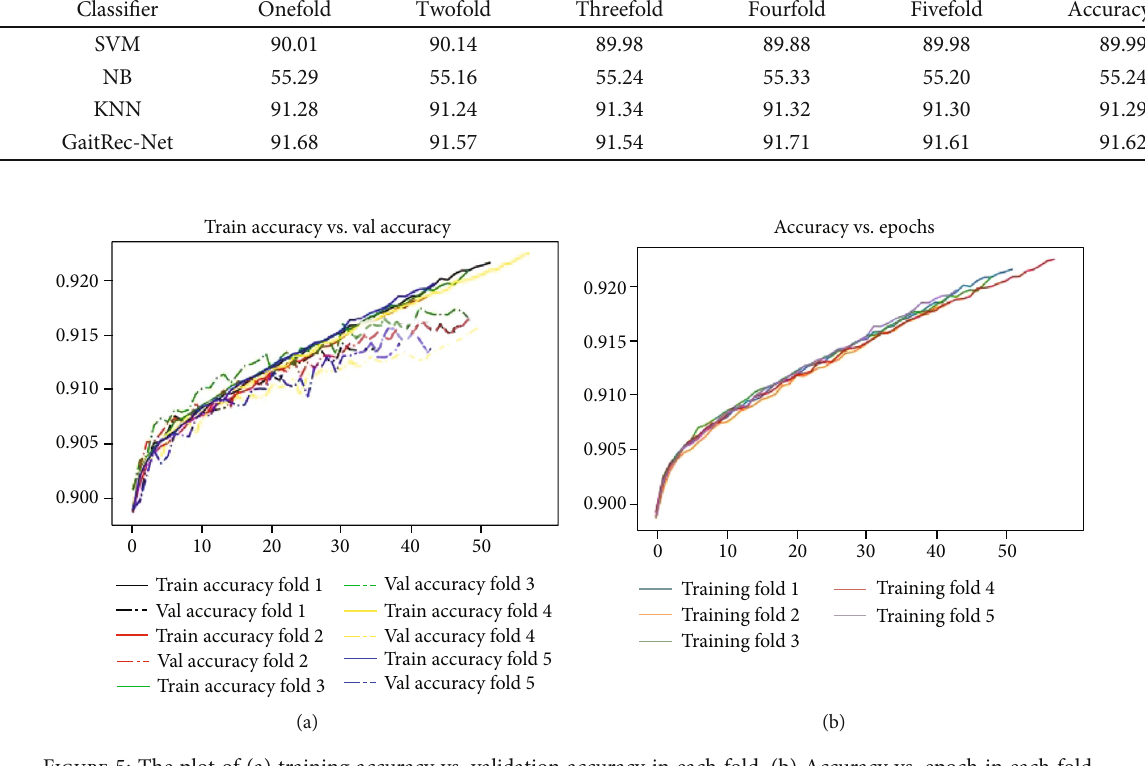
Figure 5: The plot of (a) training accuracy vs. validation accuracy in each fold. (b) Accuracy vs. epoch in each